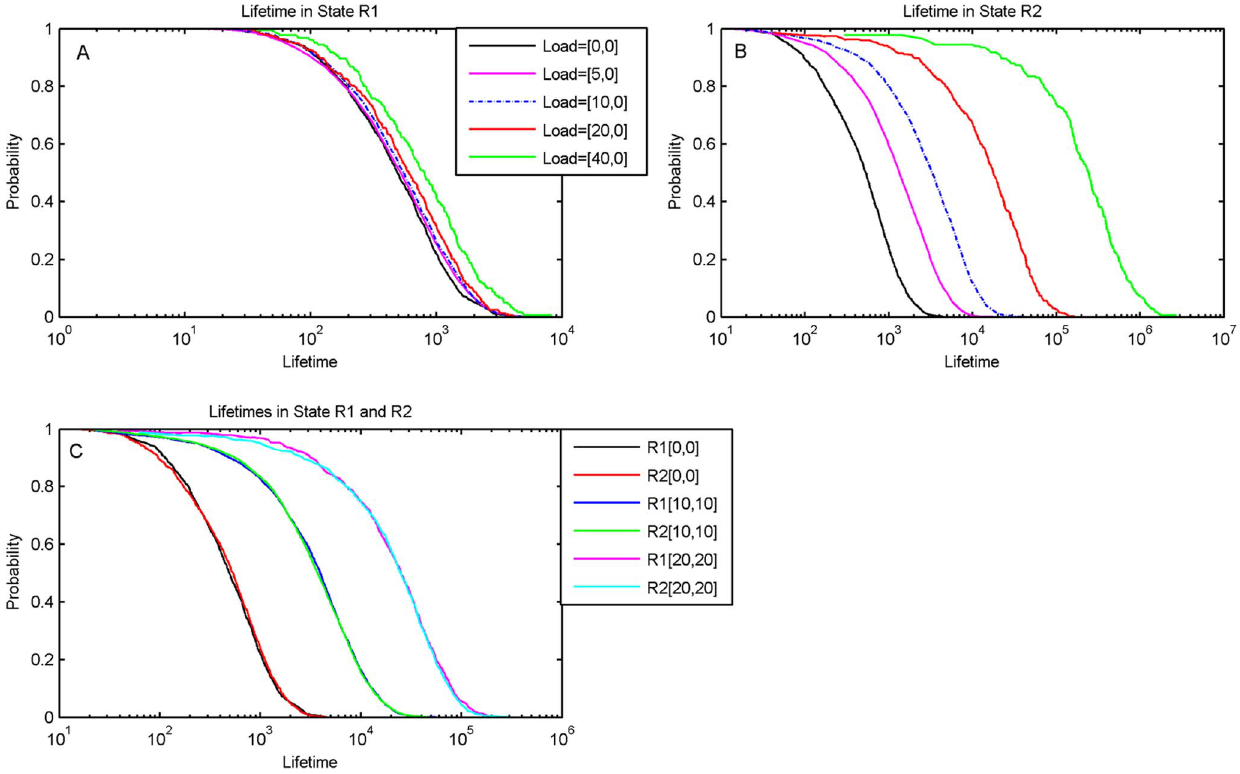
Figure 7. Distribution of the lifetimes of the toggle switch with and without loads. The time the system spent in either state R1 or state R2 was calculated from the time trace of the stochastic simulations and a histogram made of the results. The histogram is shown on a semi-log plot to accommodate the data on a single chart. (A). Lifetimes in State R1. The unloaded state is the solid curve that is to the extreme left of the others, showing that the lifetimes in state R1 increase slightly on addition of load on R1 alone due to the ‘‘same side effect’’. (B) Lifetimes in State R2 when load is on R1. The solid curve on the extreme left is the unloaded state. There is a significant increase in lifetimes due to the ‘‘opposite-side effect’’ of the load on R1. (C). Lifetimes with a balanced load, showing that both the states R1 and R2 get stabilized with a significant increase in lifetimes on addition of a small load on both sides. Note that the distributions for R1 and R2 for equivalent cases coincide as should be expected.